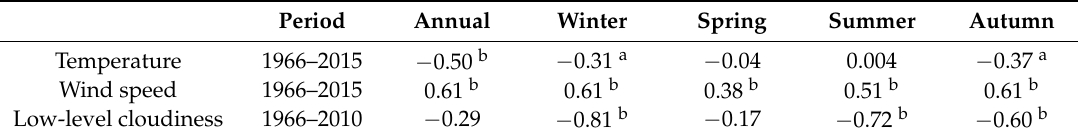
Table 2. Correlation coefficients of sunshine duration with temperature, wind speed and low-level cloudiness in the Haihe River basin.